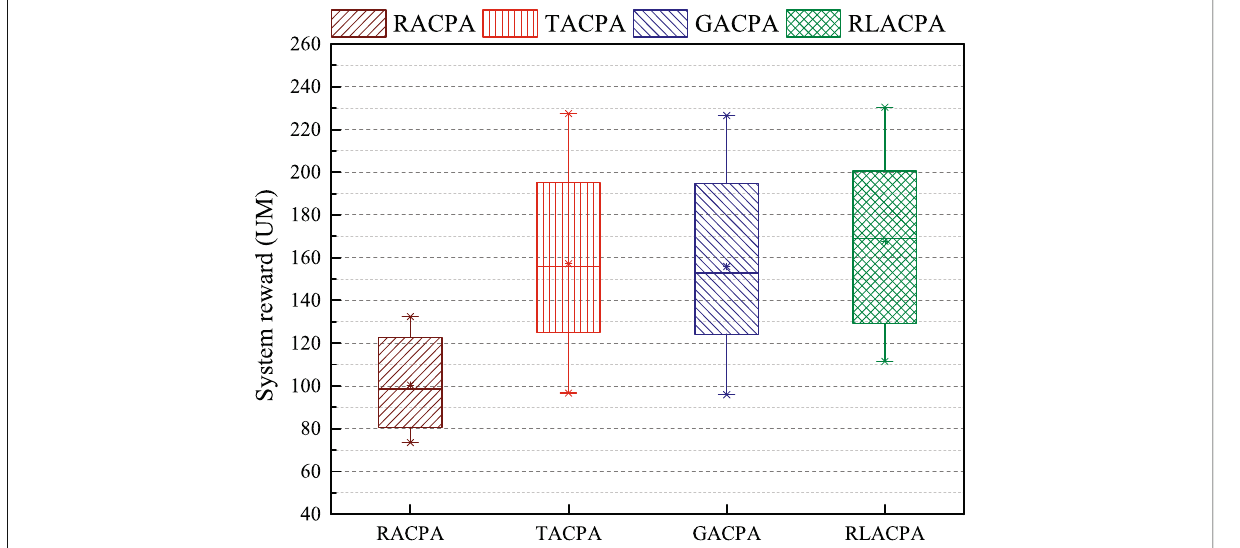
Fig. 17 SR in different scenarios. This figure is the box-plot of Table 4 and helps to visualize the data from Table 4